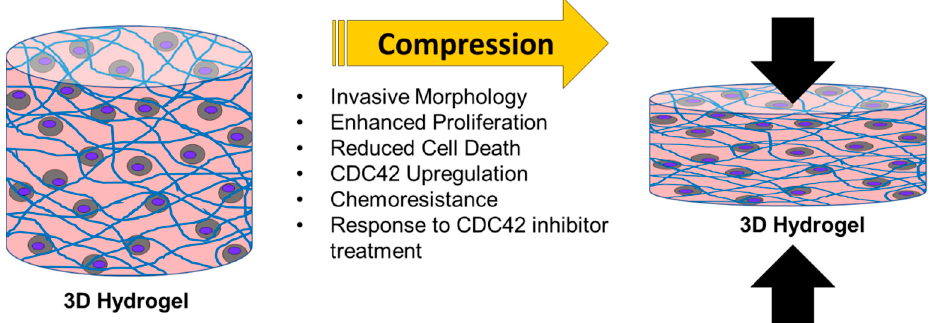
Figure 5. Summary of ovarian cancer response to compressive stimulus within a 3D agarose-collagen I hydrogel. Arrows indicate the applied compressive force (applied from the bottom) and its reactive force (represented by the top arrow). Ovarian cancer cells under compressive stimulus display an invasive morphology through their elongation and increase in aspect ratio. They also enhance proliferation and reduce overall cell death as shown in the immunohistochemical staining of ki67 and caspase-3 respectively. Compressive stimulus consistently upregulates CDC42 and chemoresistance to standard ovarian cancer drug treatments paclitaxel and carboplatin. Treatment with the CDC42 inhibitor ML141 facilitates chemotherapeutic response through enhanced cell death and reduced proliferation.